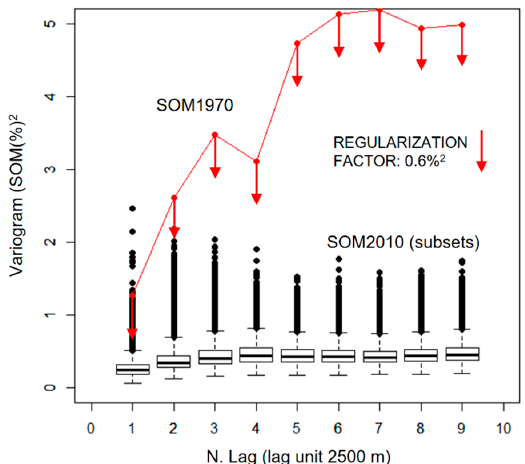
Figure 6. Boxplots reporting the statistical distribution (including extremes) of variogram values computed for each lag from the 10,000 subsamples (subsampling ratio 0.8%) drawn from SOM2010 dataset. In red variogram values for SOM1970, including the regularization factor for SOM1970